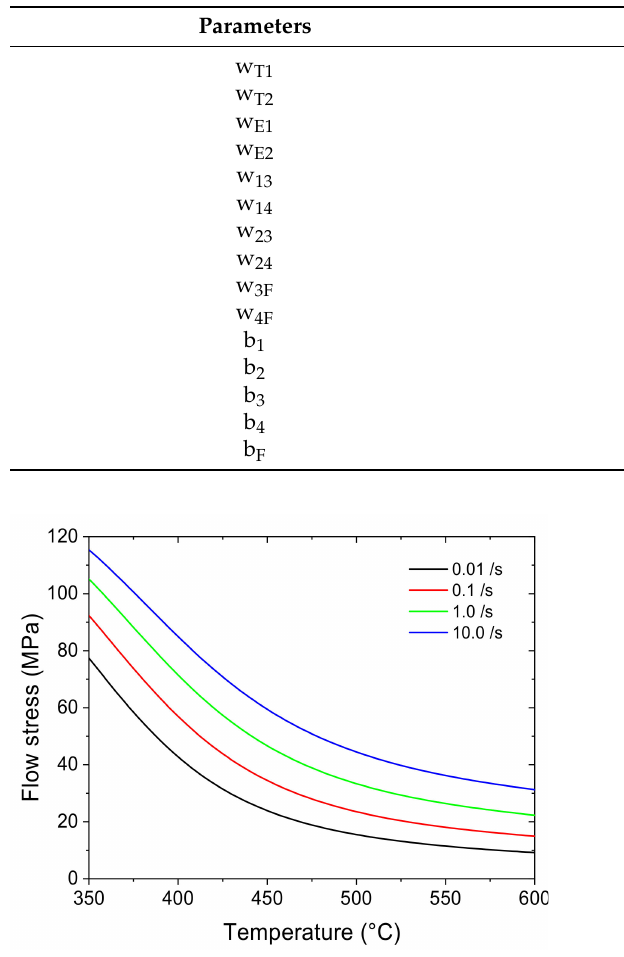
Figure 10. Predicted flow stresses by the artificial neural network.